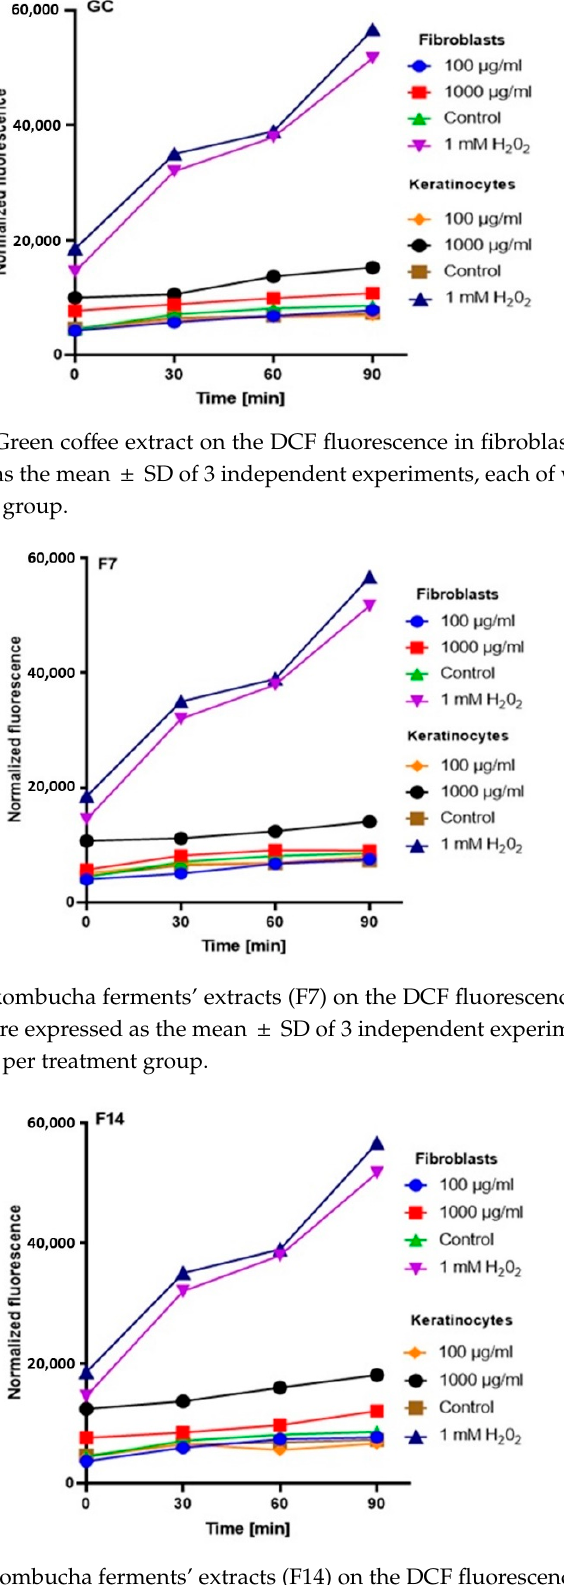
Figure 6. The effect of kombucha ferments’ extracts (F28) on the DCF fluorescence in fibroblasts and HaCaT cells. The data are expressed as the mean ± SD of 3 independent experiments, each of which consisted of 3 replicates per treatment group. 2.4. Determination of Superoxide Dismutase (SOD) Activity Prevention of threats caused by reactive oxygen species can take place at many levels, but the first line of defense is the action of ROS neutralizing enzymes. These enzymes include superoxide dismutase (SOD), which catalyzes the dismutation reaction of the superoxide radical anion to hydrogen peroxide and molecular oxygen. This reaction occurs due to the interaction of the radical anion with metal ions present in the catalytic center of the enzyme. SOD constitutes a very important antioxidant protection of the organism against oxidative stress, and their incorrect operation can lead to many pathologies. SOD is a natural enzyme present in cells and is responsible for the neutralization of harmful free radicals in order to protect DNA during intense environmental stress, being considered as an anti-aging enzyme [33–35]. Therefore, in order to comprehensively assess the antioxidant potential of the analyzed extracts, the level of superoxide dismutase in the tested samples was determined. As a result of the analysis, it was shown that the tested 14-day ferments at the concentration of 500 and 1000 µg/mL show a higher activity of the superoxide dismutase enzyme compared to the green coffee extract. In the case of the lowest analyzed concentration of 100 µg/mL, the green coffee extract showed the highest values. On the other hand, the ferments obtained after 7 and 28 days of fermentation were characterized by much lower values compared to the coffee extract and ferment obtained after 14 days of fermentation (Figure 7).